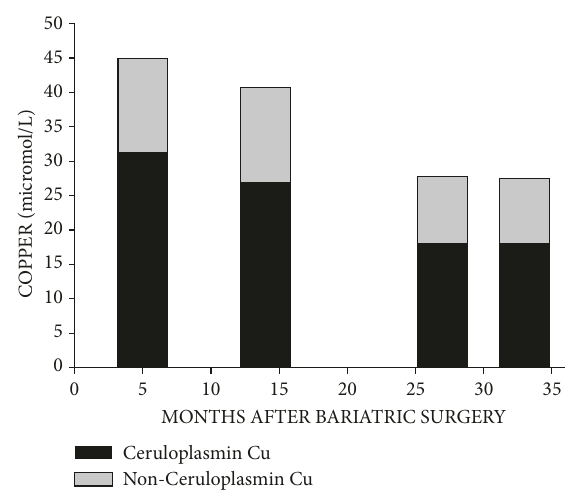
Figure 1: Concentrations of plasma copper (Cu) are shown at postoperative visits. The black bars demonstrate the contributions of ceruloplasmin copper to the plasma copper concentrations while the gray bars demonstrate the contributions of non-ceruloplasmin copper to the plasma copper concentrations. Note that there was a 38% decline in plasma copper between the 5-month postoperative visit and the postoperative visit after initiation of therapy with oral